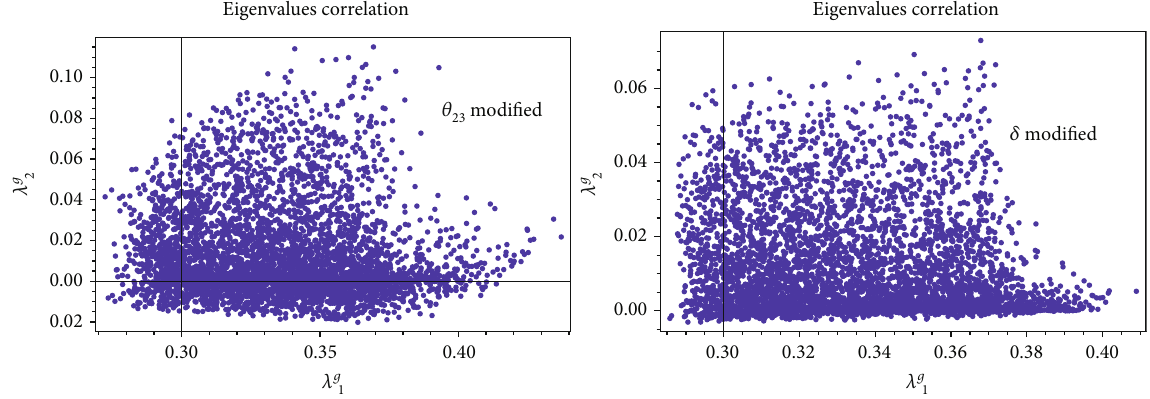
Figure 3: The eigenvalues of the matrix (cid:2) P g . The conventions of the mixing parameters are the same as those in Figure